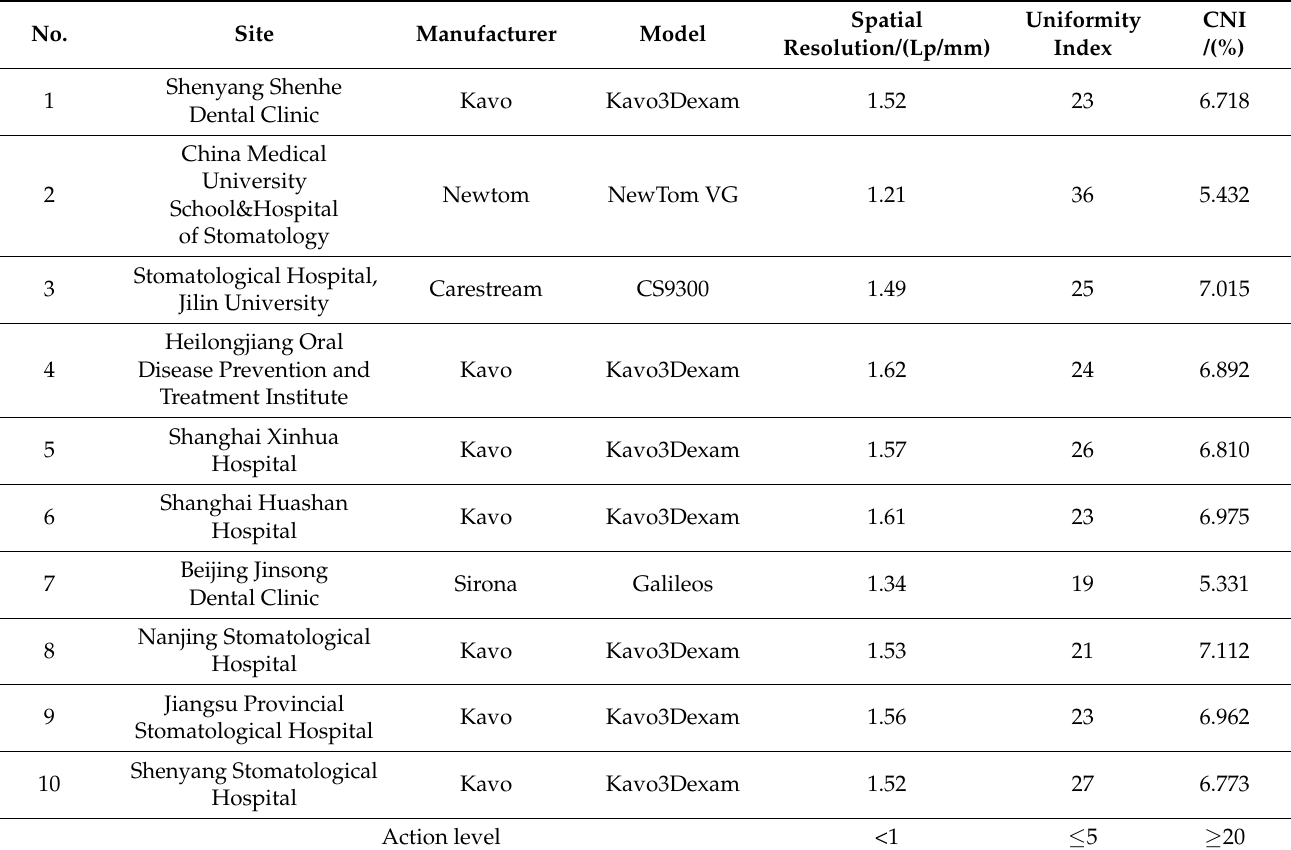
Table 2. Experimental results of the image metric